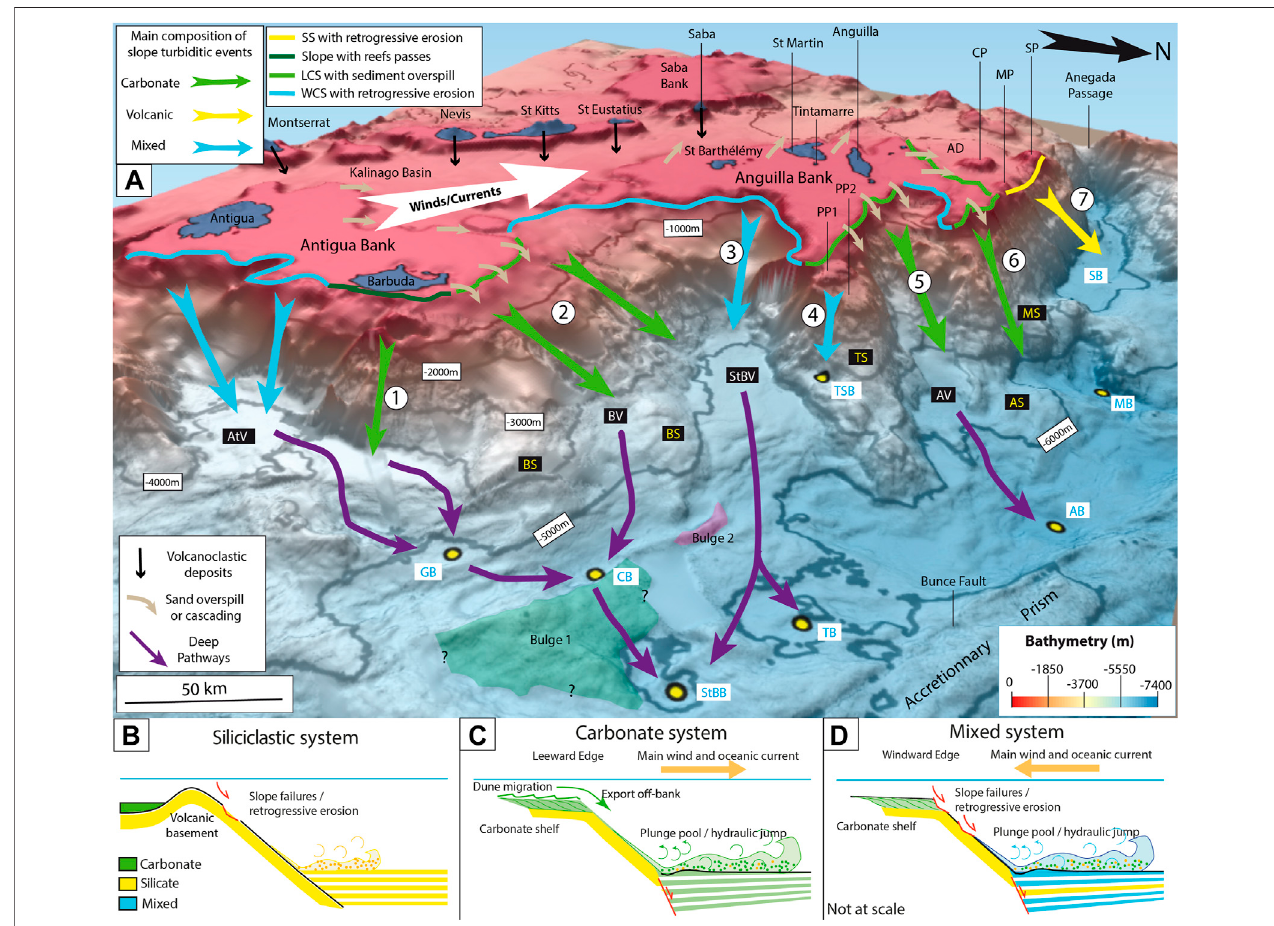
FIGURE 13| (A) 3D block diagram identifying the nature ofthe sources ofthe turbidity currents and the associated mechanisms. Purplearrows correspond to the main deep pathways. The numbers (1 – 7) refer to the name of the sedimentary systems in Tab.2. Legend of the slopes: LCS: Leeward Carbonate Slope, SS: Siliciclastic Slope, WCS: Windward Carbonate Slope. AB: Anguilla Basin, AD: Anguilla Depression, AS: Anguilla Spur, AV: Antigua Valley, AV: Anguilla Valley, BB: Barbuda Basin, BS: Barbuda Spur, BV: Barbuda Valley, CP: Crocus Platform, MB: Malliwana Basin, MP: Malliwana Platform, MS: Malliwana Spur, PP1: Paleo-Platform 1, PP2: Paleo-Platform 2, StBV: St-Barthélémy Valley, SB: Sombrero Basin, SP: Sombrero Platform, TS: Tintamarre Spur. The Vertical Exaggeration is x5. (B) Scheme of a siliciclastic sedimentary system dominated by volcanic input. (C) Schemeofasedimentary system dominated by carbonate input. (D) Scheme of asedimentarysystem with mixed